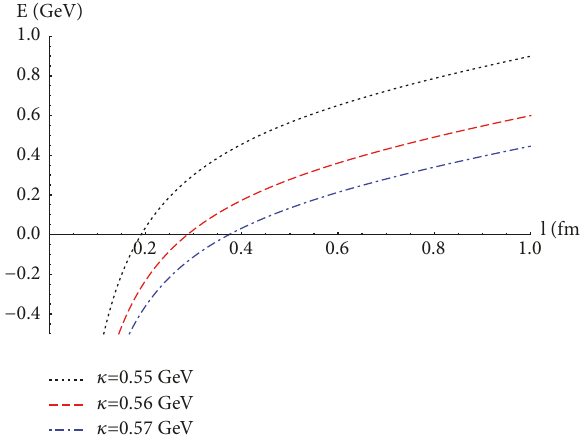
Figure 2: 𝐸 𝑅𝑒𝑛. against ℓ obtained directly from (8) and (15) through numerical integration, for three particular values of 𝜅 : 0.55 GeV, 0.56 GeV, 0.57 GeV and their respective approximate values of 𝑛 : 1.2, 1.3, 1.4. These curves correspond to possible matches with the Cornell potential. The values 𝑛 come from Figure 1 for each curve corresponding to a given 𝜅